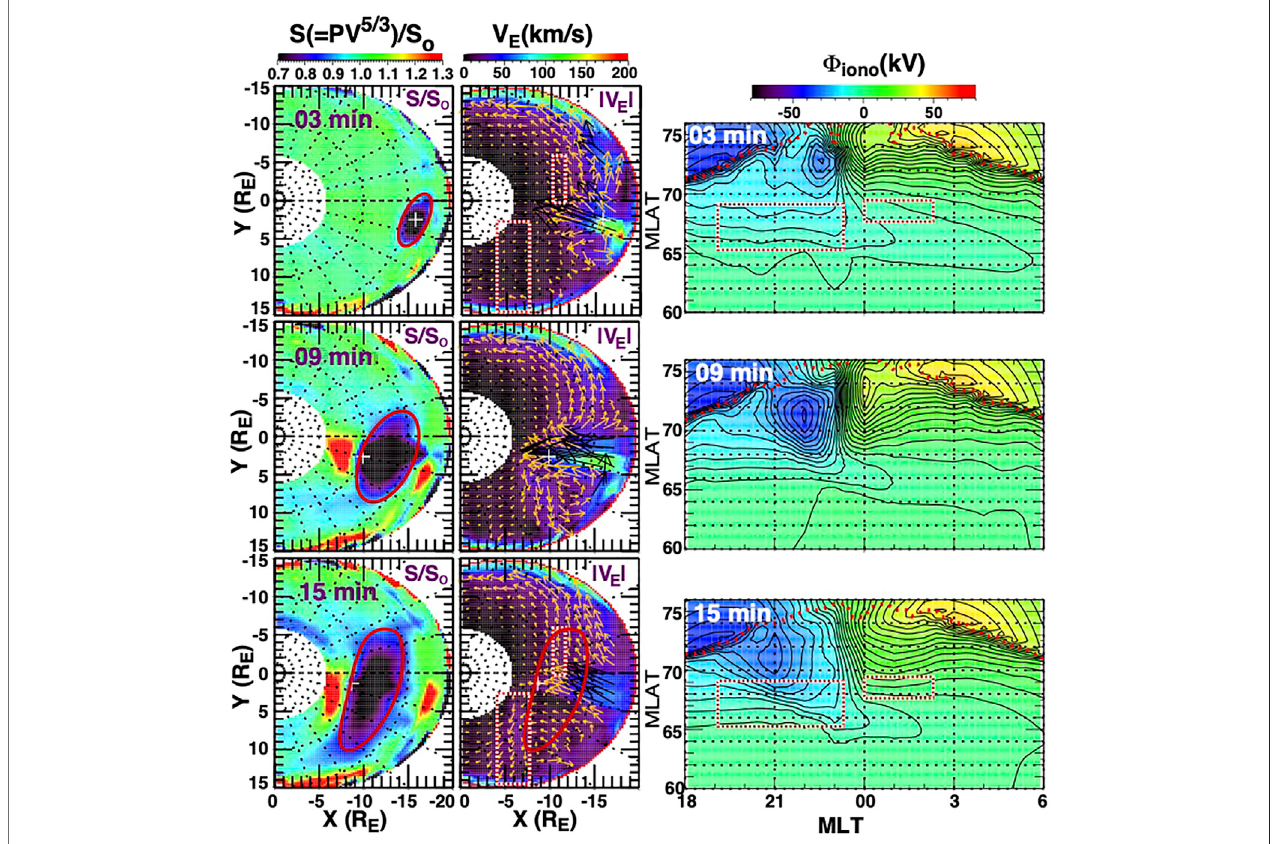
FIGURE 2 | UCLA-RCM results in the equatorial plane and ionosphere from Run two of Wang et al. (2018b). Format is the same as Figure 1 , and all model parameters were the same except the perturbation with centered at 23 MLT.